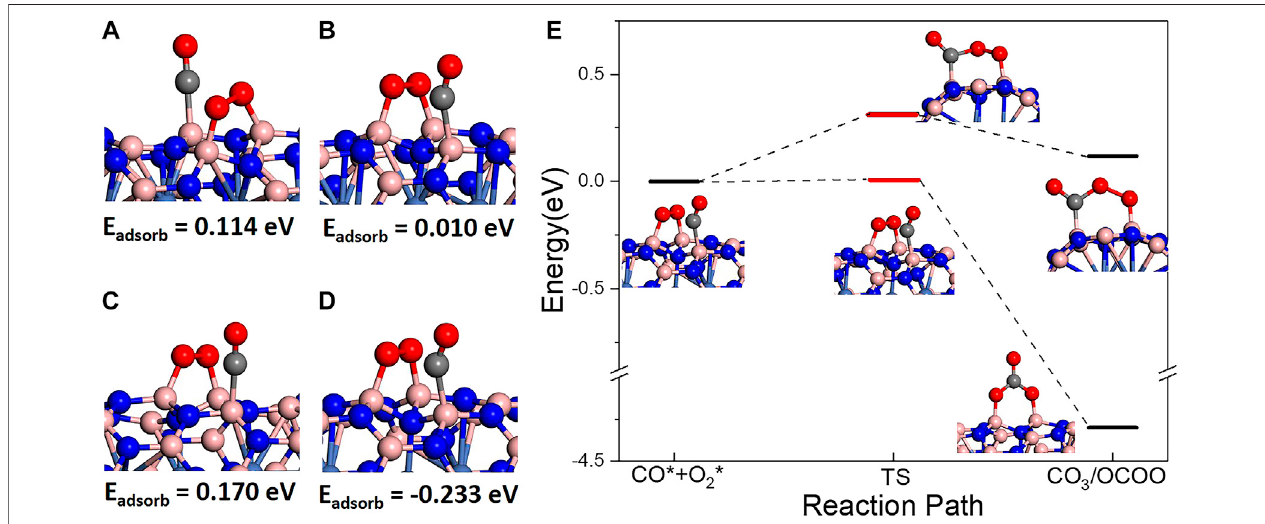
(A) B (B) B (C) B (D) B 1 site in BN(8.0)/Ni, 2 site in BN(8.0)/Ni and 1 site in BN(9.0)/Ni, 2 site in